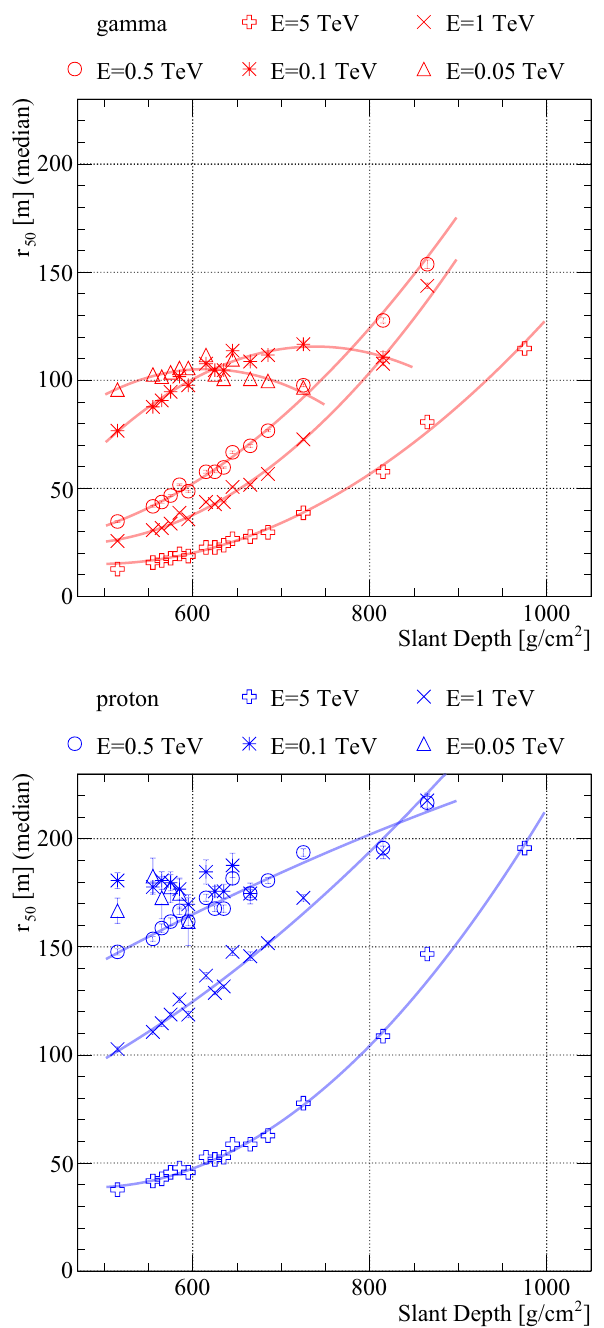
Fig. 9 Lateralshower extent parameter r 50 as afunction of slantdepth. The points correspond to the median value of r 50 . The top panel shows the dependency for γ -ray showers while the behaviour for protons is shown in the bottom panel. The results of fitting a second order polyno- mial are shown as solid lines, fit parameters are given in Appendix B. Each data point corresponds to the slant depth of a combination of zenith angle and ground-level from Fig. 14. Statistical uncertainties are of similar size as the markers or smaller